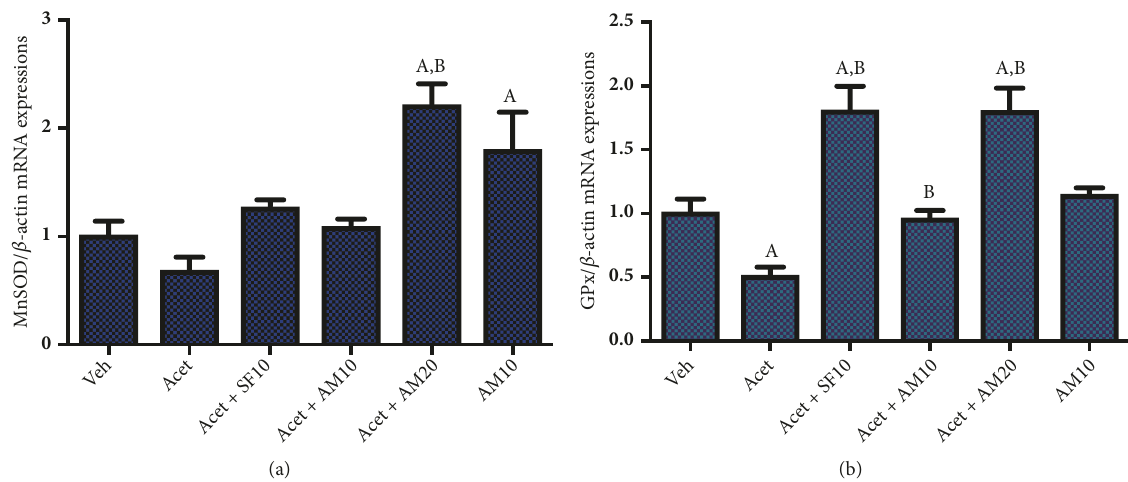
Figure 10: Effect of alpha mangostin on antioxidant defenses mRNA expressions of (a) MnSOD/ 𝛽 -actin and (b) GPx/ 𝛽 -actin, after LX-2 cells were treated with alpha mangostin with or without acetaldehyde induction. Results were presented as mean ± SEM. A: p < 0.05 versus untreated group, B: p < 0.05 versus acetaldehyde group. Veh: vehicle only, Acet: acetaldehyde 100 𝜇 M, Acet + SF10: acetaldehyde 100 𝜇 M + sorafenib10 𝜇 M, Acet+ AM10:acetaldehyde 100 𝜇 M + alpha mangostin 10 𝜇 M, Acet+ AM20:acetaldehyde 100 𝜇 M + alpha mangostin 20 𝜇 M, AM 10: alpha mangostin 10 𝜇